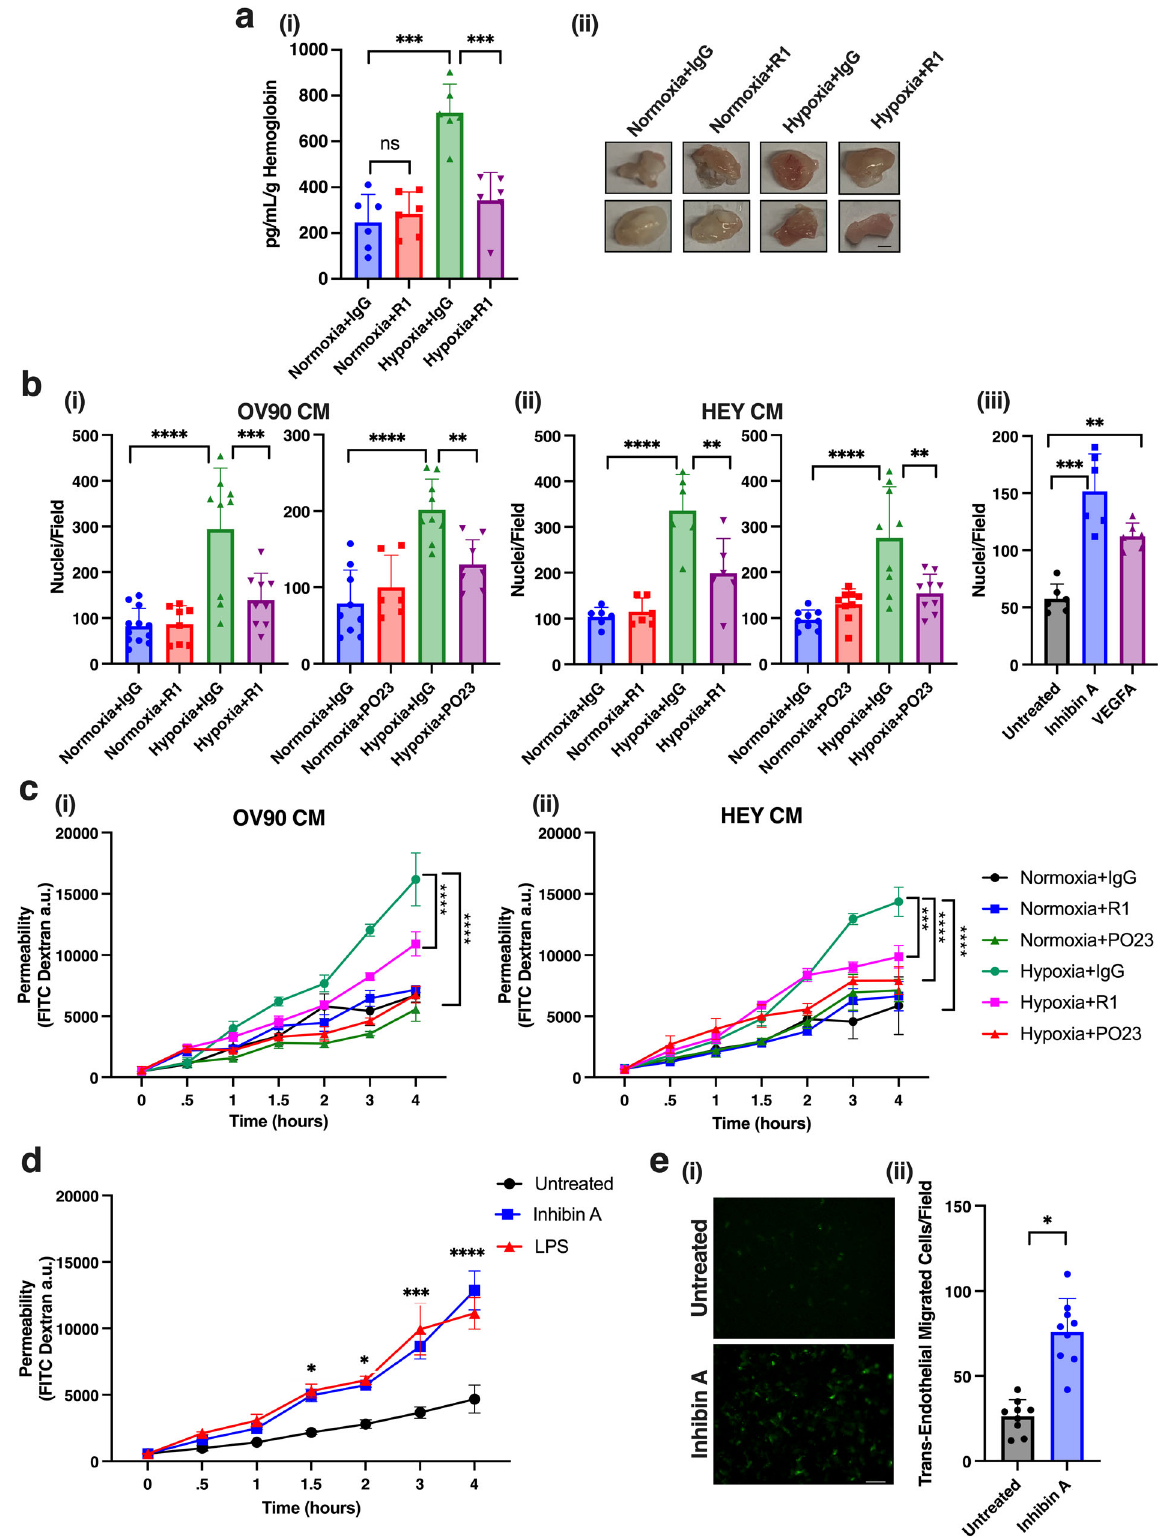
are critical to invasion and extravasation of cancer cells during metastasis 43 , we tested whether inhibin induced vascular perme- ability facilitates tumor cell extravasation. To test this, we used a trans-endothelial cell migration assay to mimic the process. HEY tumor cells infected with GFP adenovirus to distinguish them from migrated non-GFP endothelial cells were plated on top of